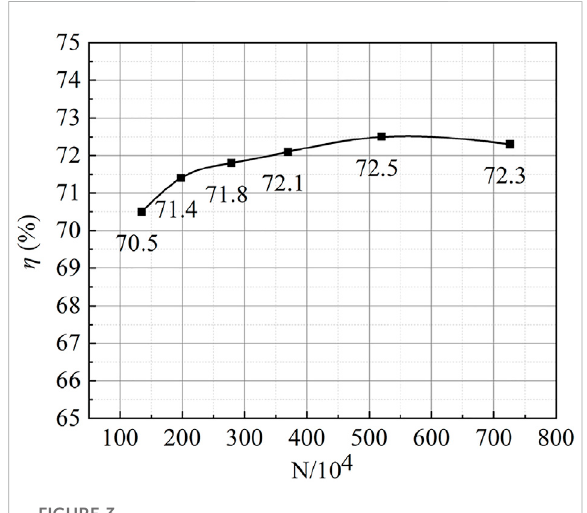
FIGURE 3 Ef fi ciency of axial- fl ow pump system with different numbers of grid